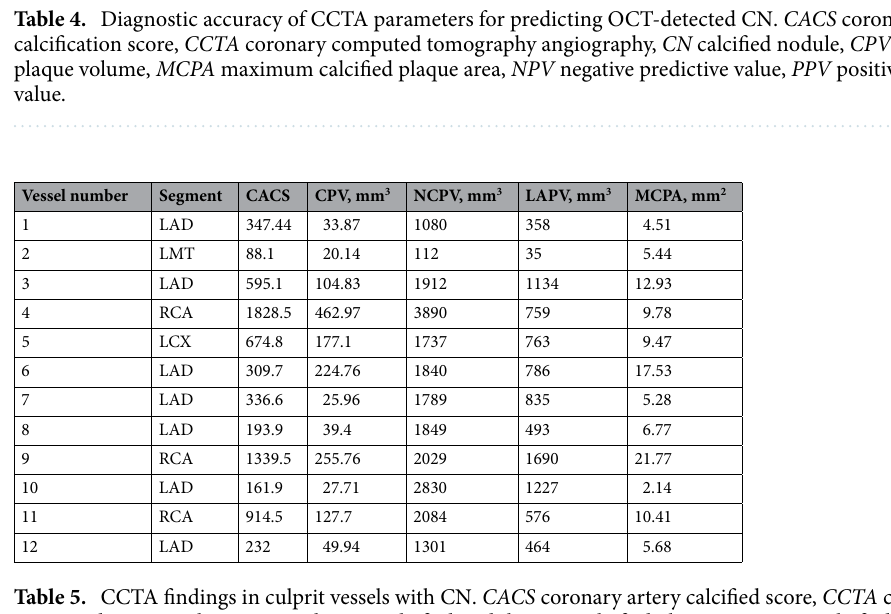
Table 5. CCTA findings in culprit vessels with CN. CACS coronary artery calcified score, CCTA coronary computed tomography angiography, CN calcified nodule, CPA calcified plaque area, CPV calcified plaque volume, LAD left anterior descending, LAPV low-attenuation plaque volume, LCX left circumflex, LMT left main trunk, MCPA maximum calcified plaque area, NCPV non-calcified plaque volume, RCA right coronary